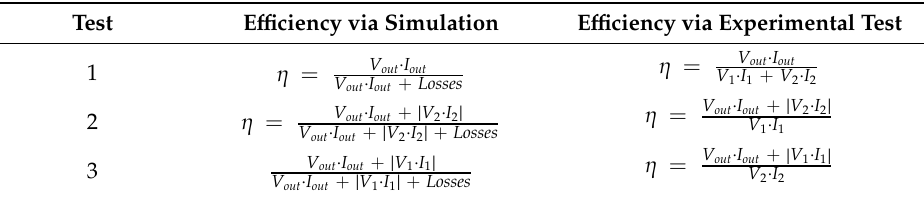
Table 3. E ffi ciency evaluation.